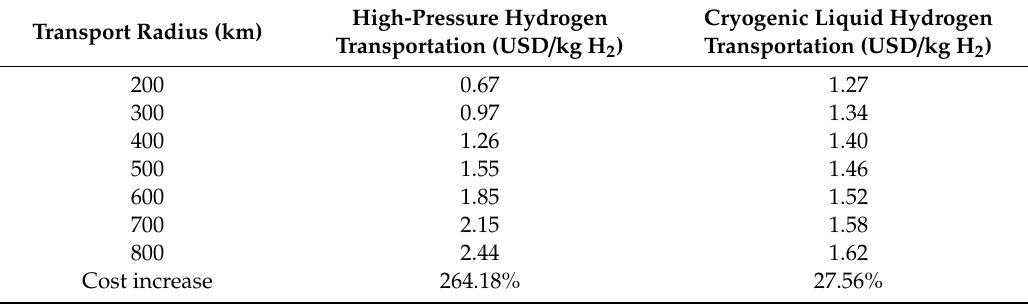
Table 8. Hydrogen transportation cost.